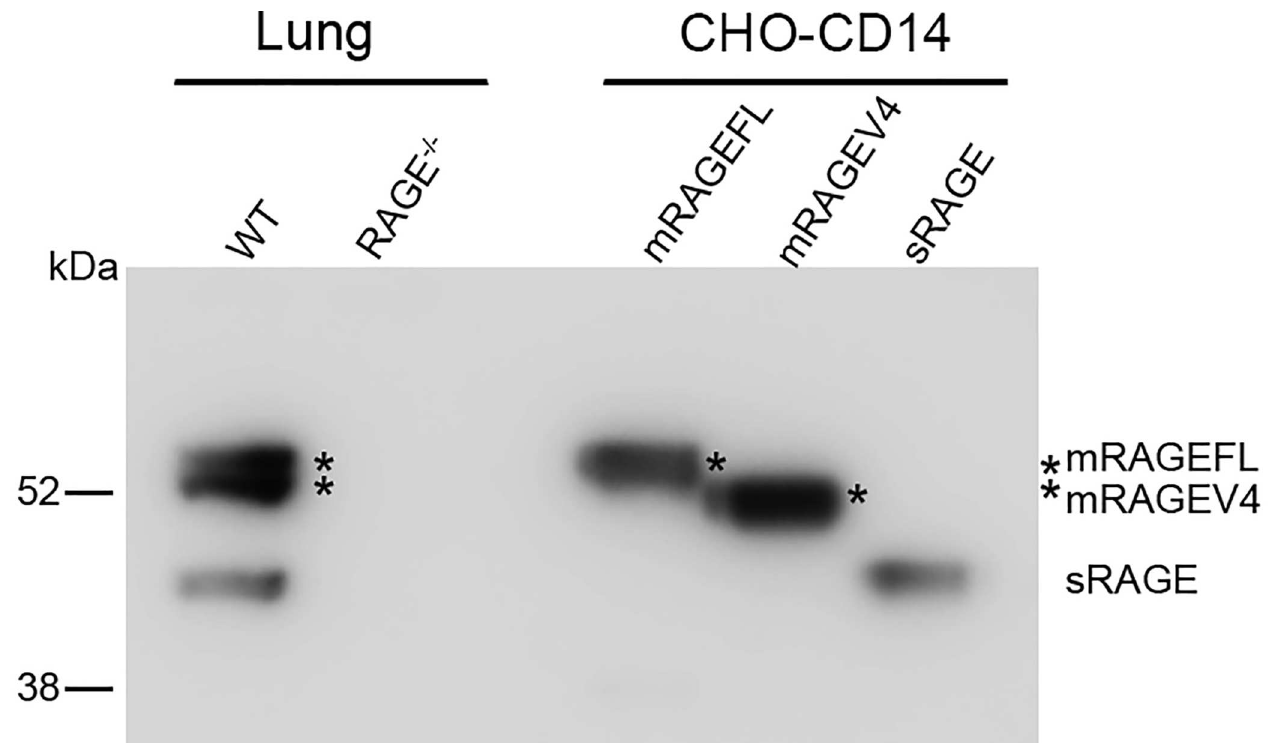
Fig 1. Re-examinationof RAGE expression in murine lung. Lung lysates preparedfromwild-type(WT)and RAGE -/- mice, and cell lysates from CHO-CD14 cells individually transfected with untaggedmRAGEFL, mRAGEV4 and sRAGE cDNA were resolved in SDS 4–12% precastBis-Tris gel and electrophoresed for 1.5 h. Anti-RAGE antibodies (H-300)were used for westernblotting. * marksthe resolved mRAGEFL and mRAGEV4.